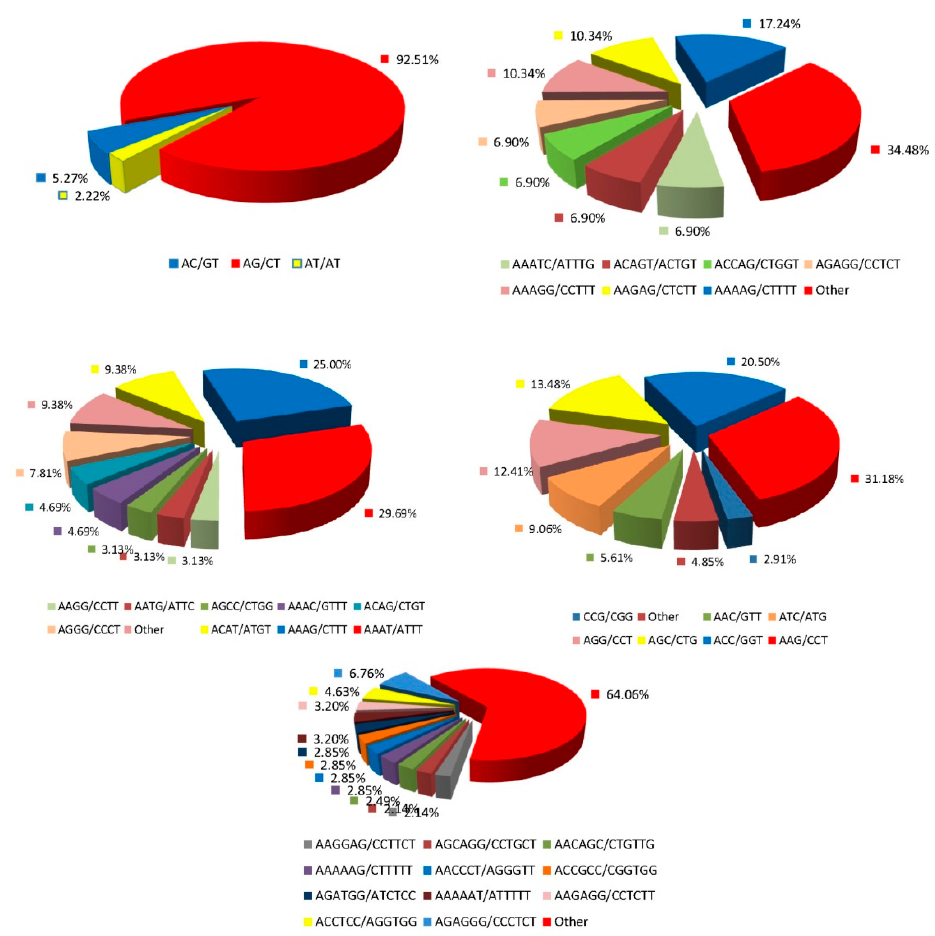
Figure 1. Frequency distribution of different SSR (simple sequence repeat) motifs of the specific SSR repeat motifs in the transcriptome of L. formosana .